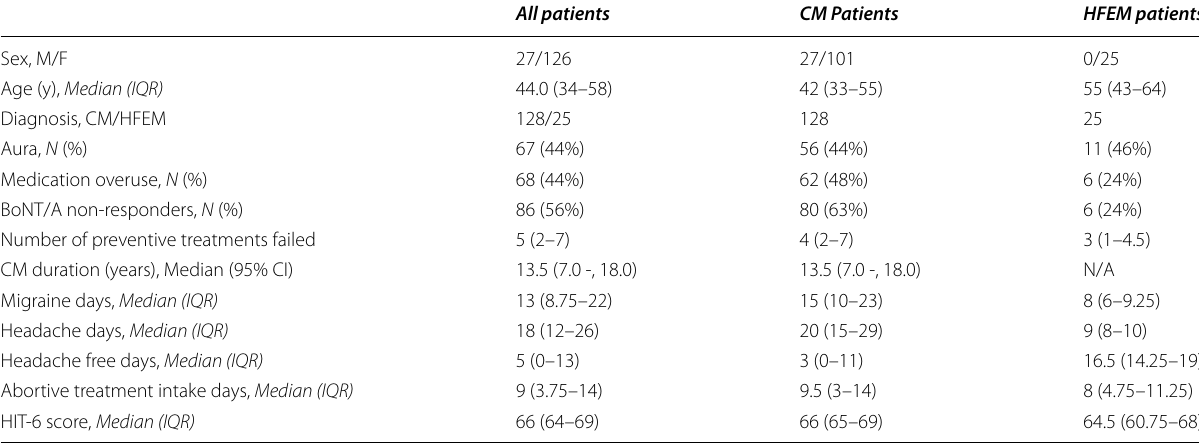
Table 2 Demographic and clinical characteristics at baseline of all migraine patients ( N magnetic